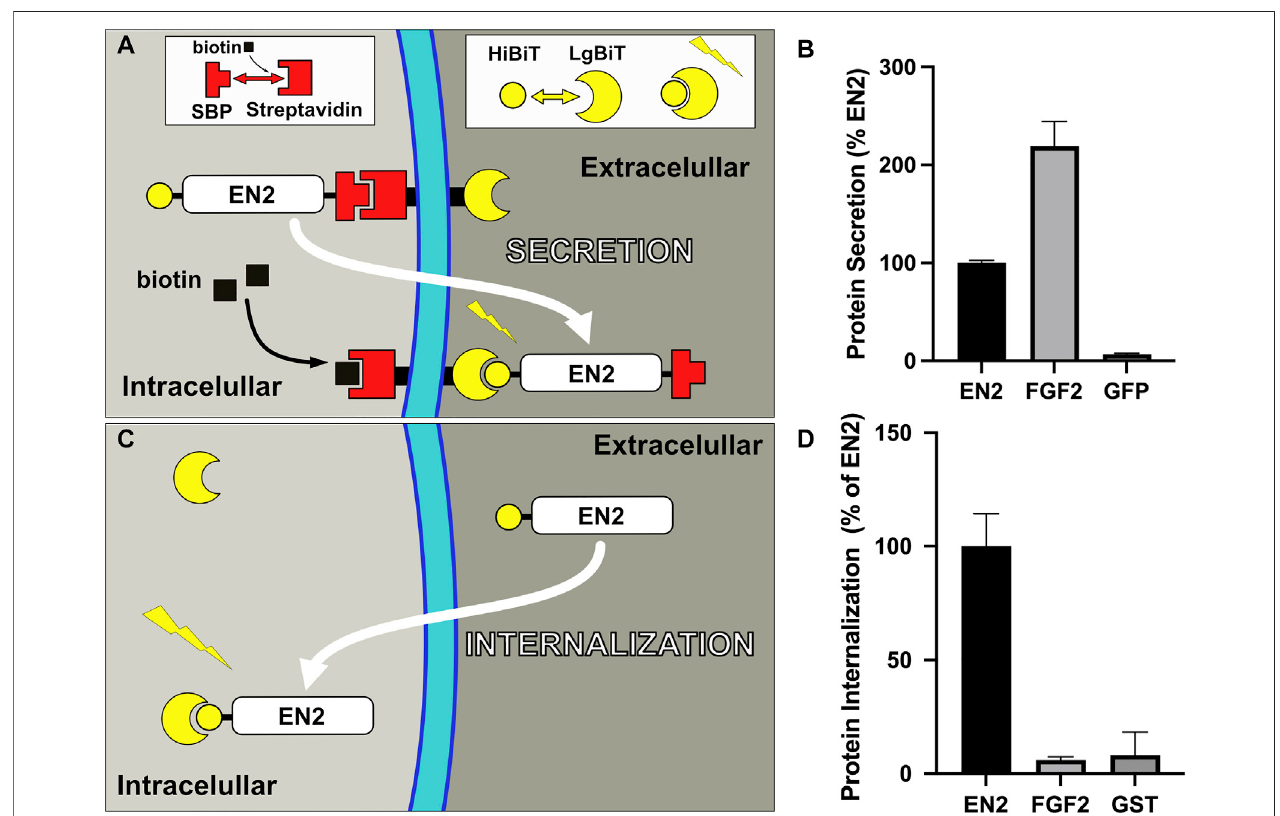
FIGURE1 | Quantitative translocation assays. (A) Secretion assay (TransRush): Thanksto the addition of aSBP tag, EN2 ishooked at the inner side of theplasma membrane using the Rush system and can be released upon biotin addition. The presence of a second tag (HiBiT) allows monitoring secretion of EN2 upon release through complementation with the complementary Nanoluc fragment (LgBiT) present at the cell surface. (B) Quanti fi cation of the secretion ofthe indicated proteins with the TransRush assay. Luciferase activity is quanti fi ed 1 h after biotin addition. (C) Internalization assay: Cytosolic delivery of a HiBiT-tagged recombinant EN2 protein loaded in the medium is monitored through complementation with the complementary Nanoluc fragment (LgBiT) present in the cytosol of the recipient cell. (D) Cytosolic delivery of the indicated proteins is quanti fi ed 30 min after addition in the medium ( B , D from ref 22).